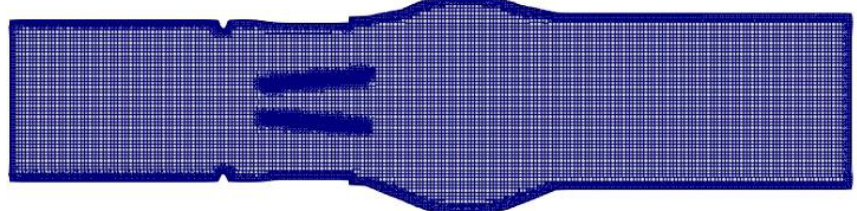
Figure 4. Mesh quality of the MHV model (Center Section View).